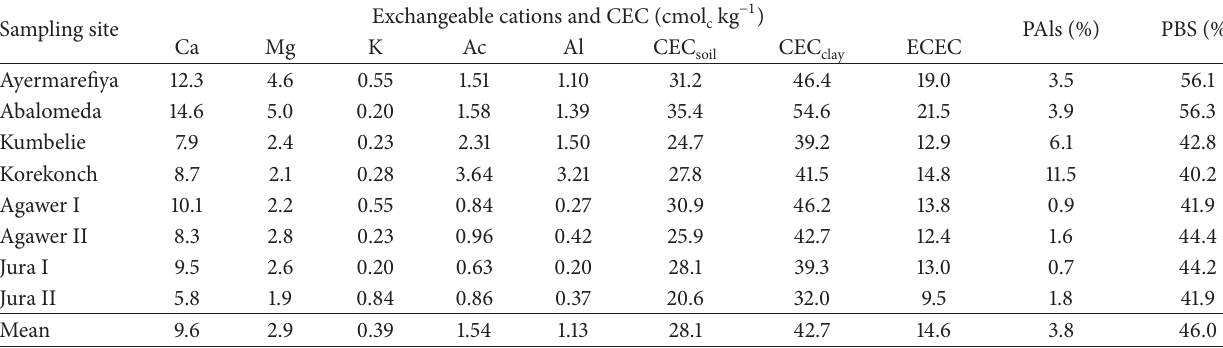
Table 4: Exchangeable cations and exchange